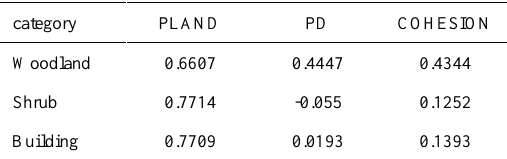
Table3 Moran’s I coefficients of the